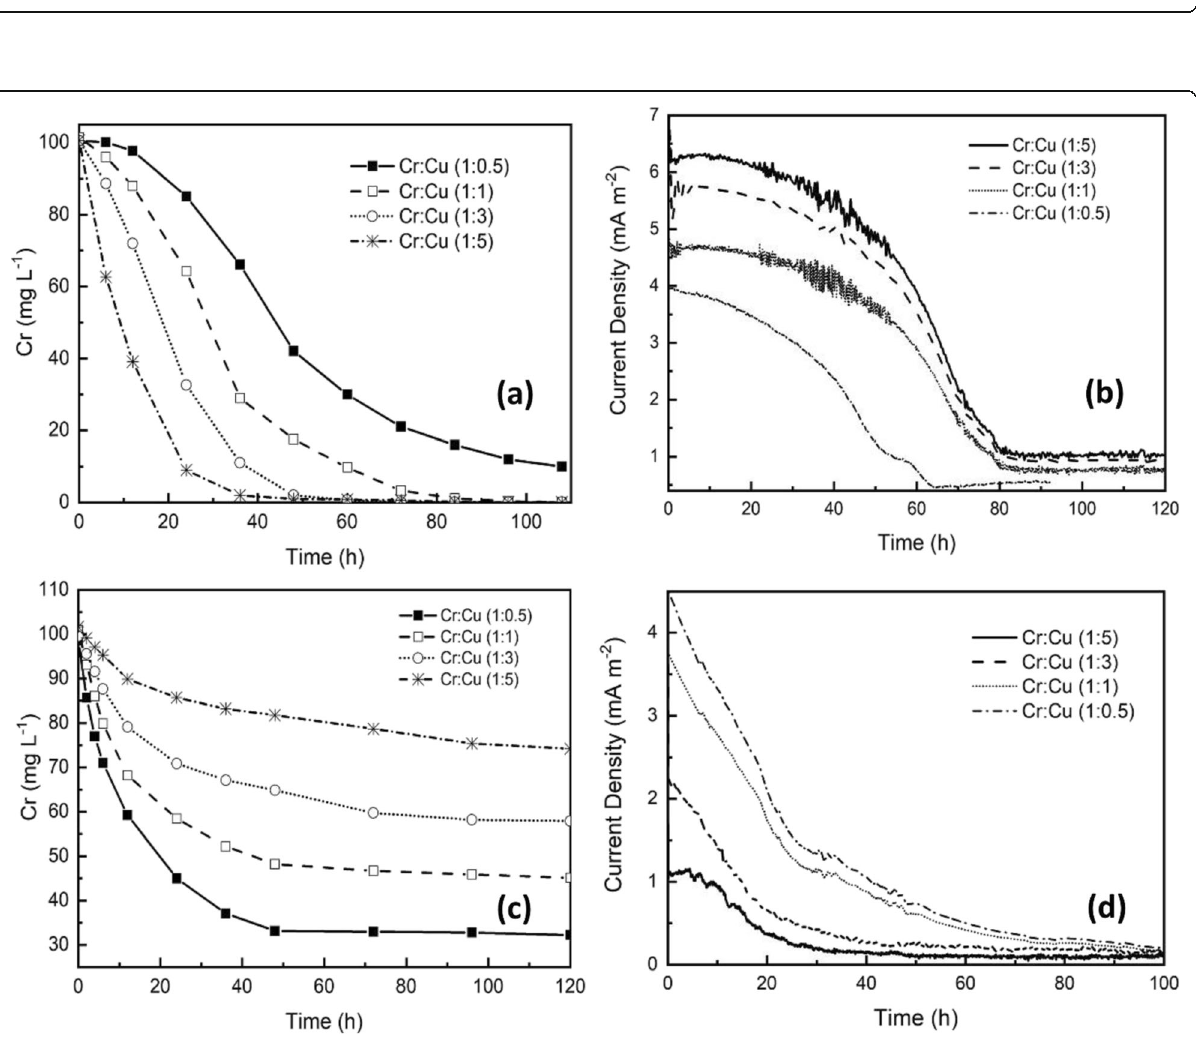
Fig. 5 Effect of Cu 2+ concentration at pH 2: a temporal reduction of Cr 6+ ; b response in the current density. Effect of Cu 2+ concentration at pH 4: a temporal reduction of Cr 6+ ; b response in the current